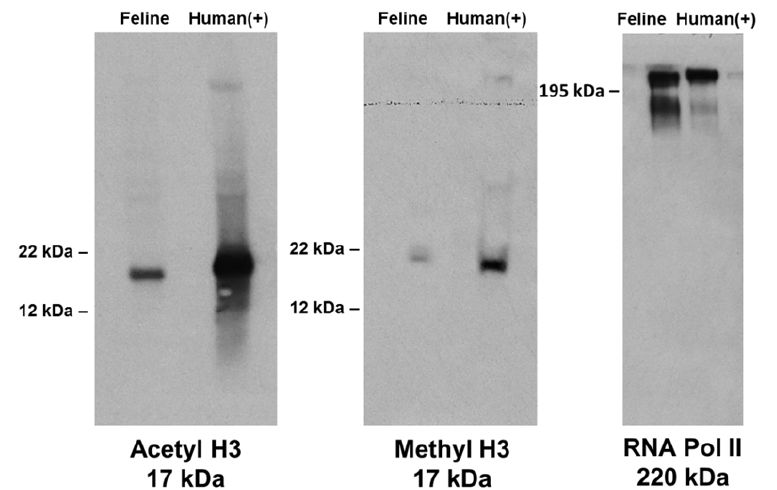
Figure 2. Validation of three antibodies for use in feline ChIP assays. Feline PBMC protein lysate (left) is compared to a positive control of human fetal kidney (293) cell protein lysate (right). Appropriate-sized bands are evident in Western blots incubated with primary anti-acetylated histone H3 (17 kDa), anti-methylated histone H3 (17 kDa), and anti-RNA Polymerase II (220 kDa) antibodies in both